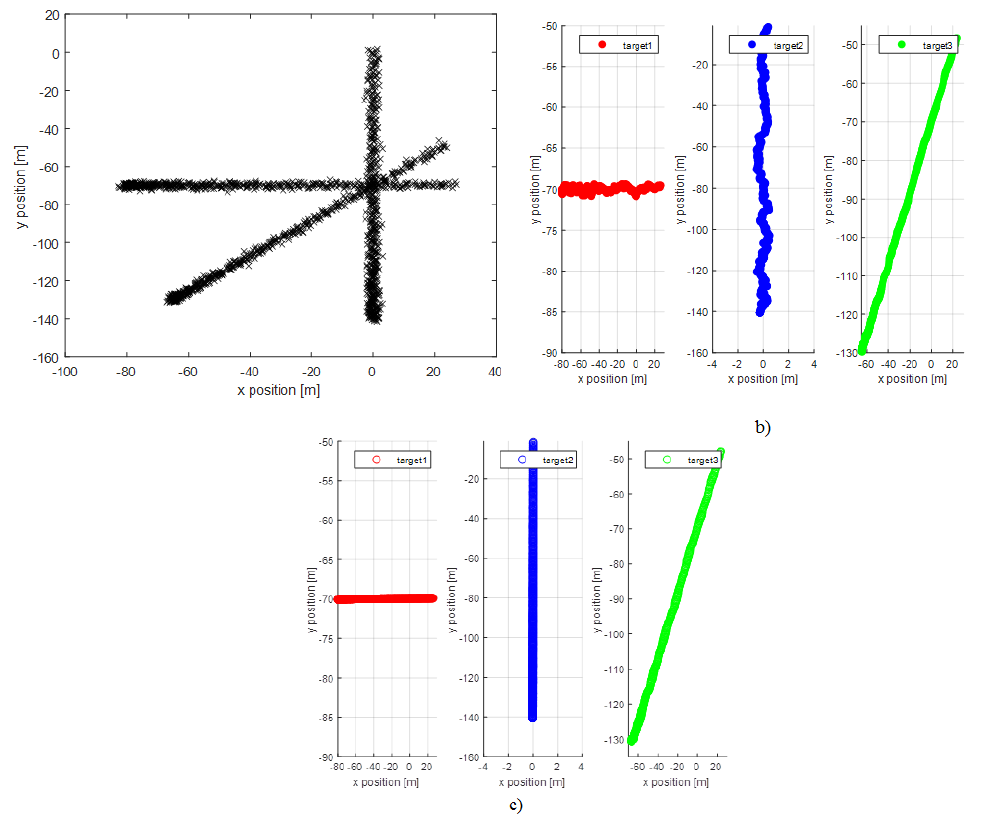
Figure 5. Partial and final results of the third experiment with simulated data: ( a ) spatial spreading of targets after data association; ( b ) the effect of Kalman filtering; ( c ) the effect of the explicit polynomial fitting method.